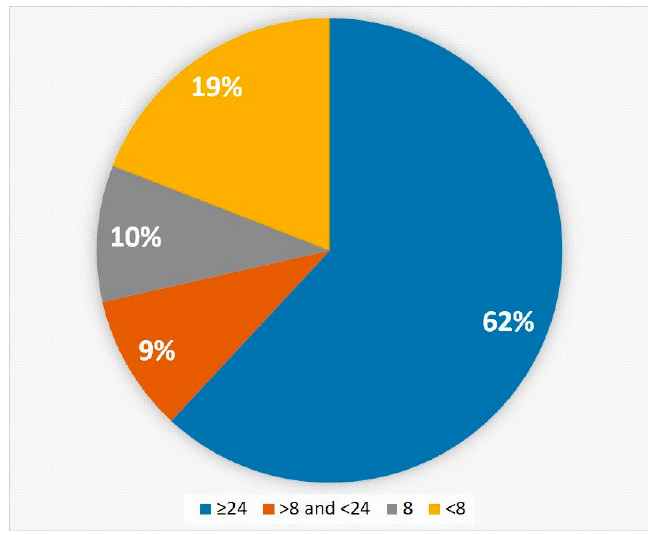
Figure 3. Sampling intervals adopted in the reviewed studies.